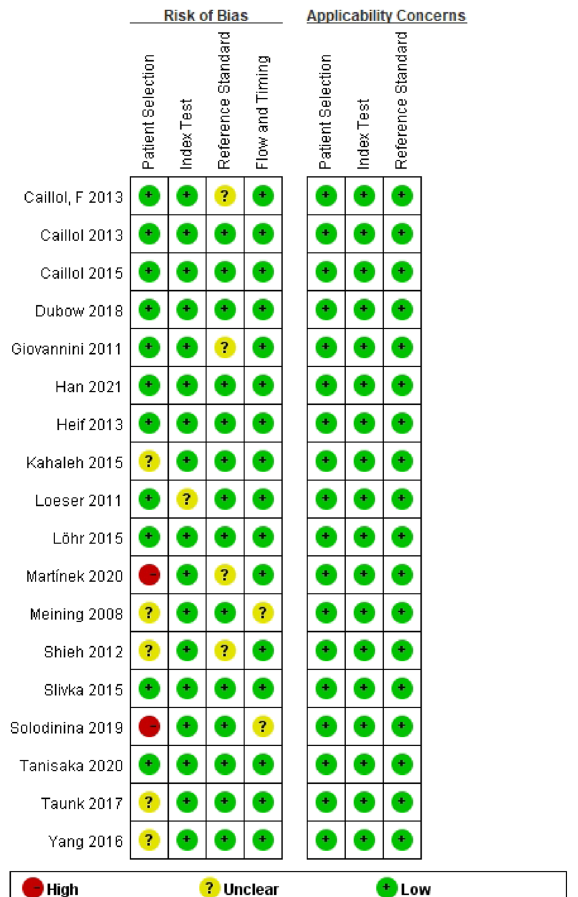
Figure 2. The quality of included studies and the risk of